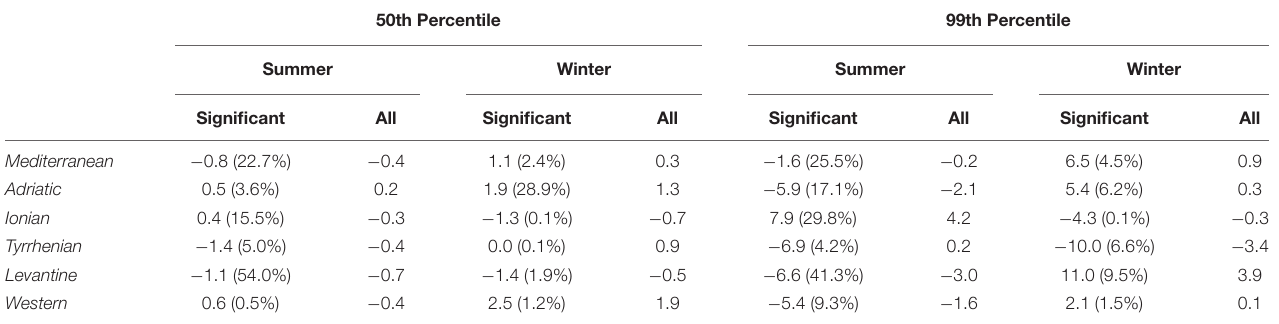
Averages over the points where the trends are significant (black dots in Figure 9 ; tested with Mann-Kendall test and 90% confidence interval) and over all the points. Value between parentheses is the percentage of points with statistically significant trends in a (sub-) basin with respect to all the points in the (sub-)